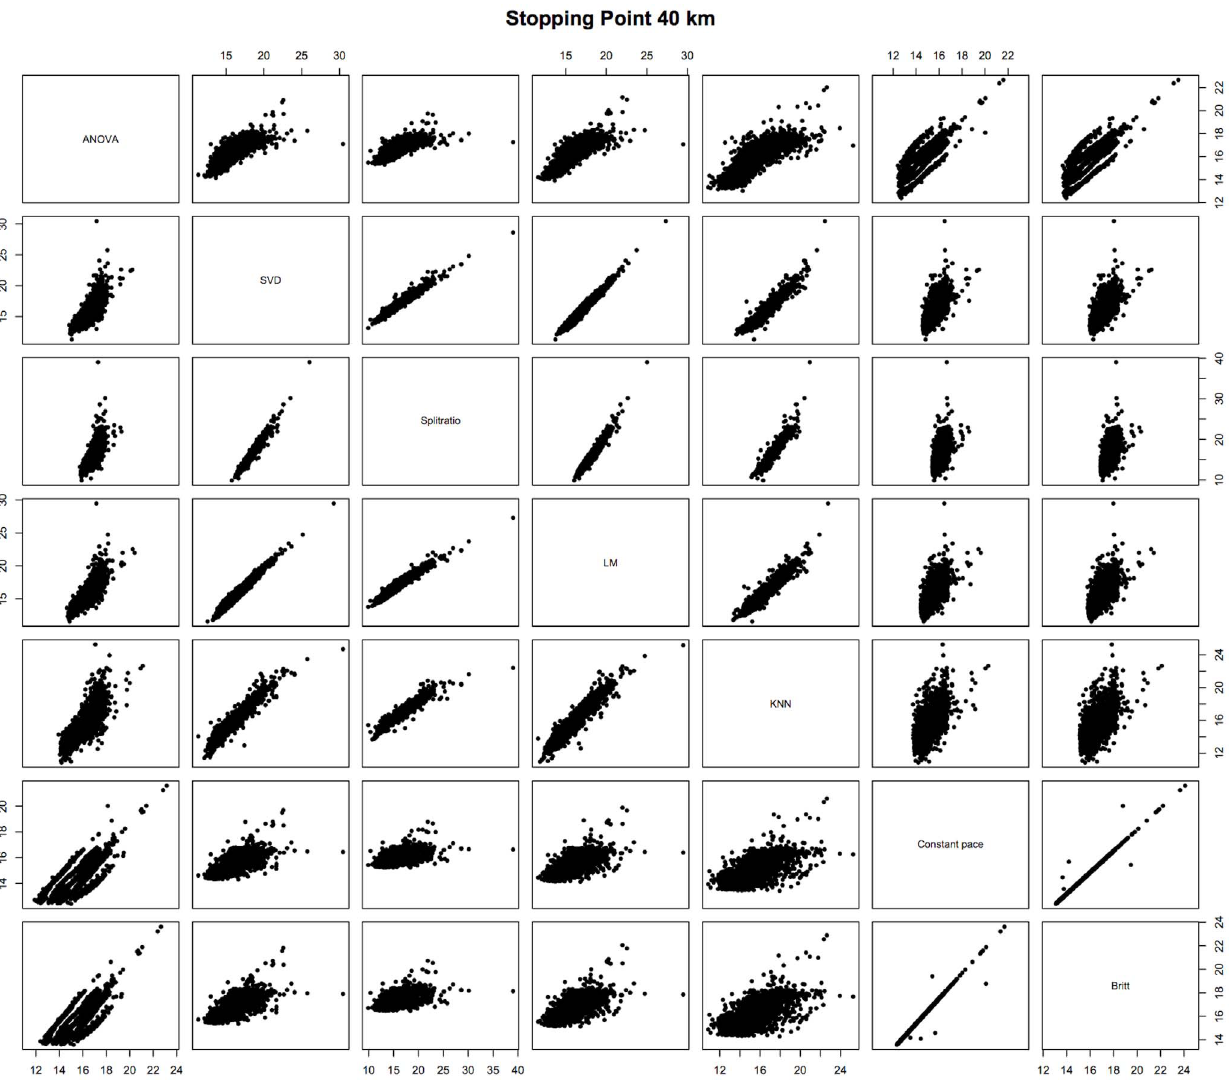
Figure 7. 2013 Prediction comparisons. Plots of the predicted 40 km to finish times for the runners who had to stop the race before the 40 km mark. Each plot corresponds to the predicted times for the methods listed in the same row and the same column as the plot. For example, the scatterplot in row 2 and column 1 has the ANOVA method’s predicted 40 km to finish times on the horizontal axis and the SVD method’s predicted 40 km to finish times on the vertical